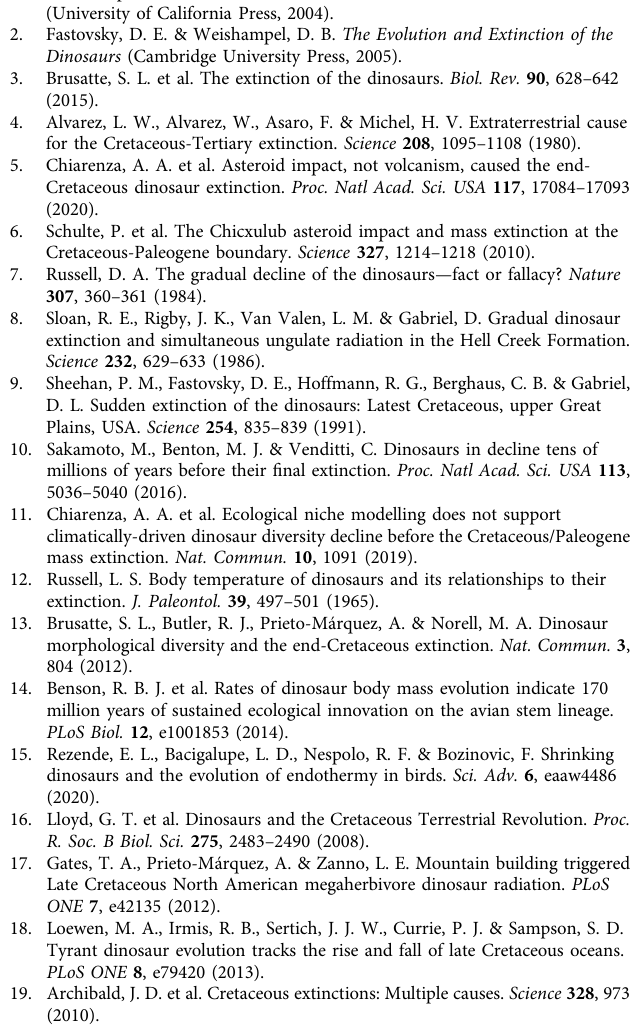
Figshare digital data repository (https://doi.org/10.6084/m9. fi